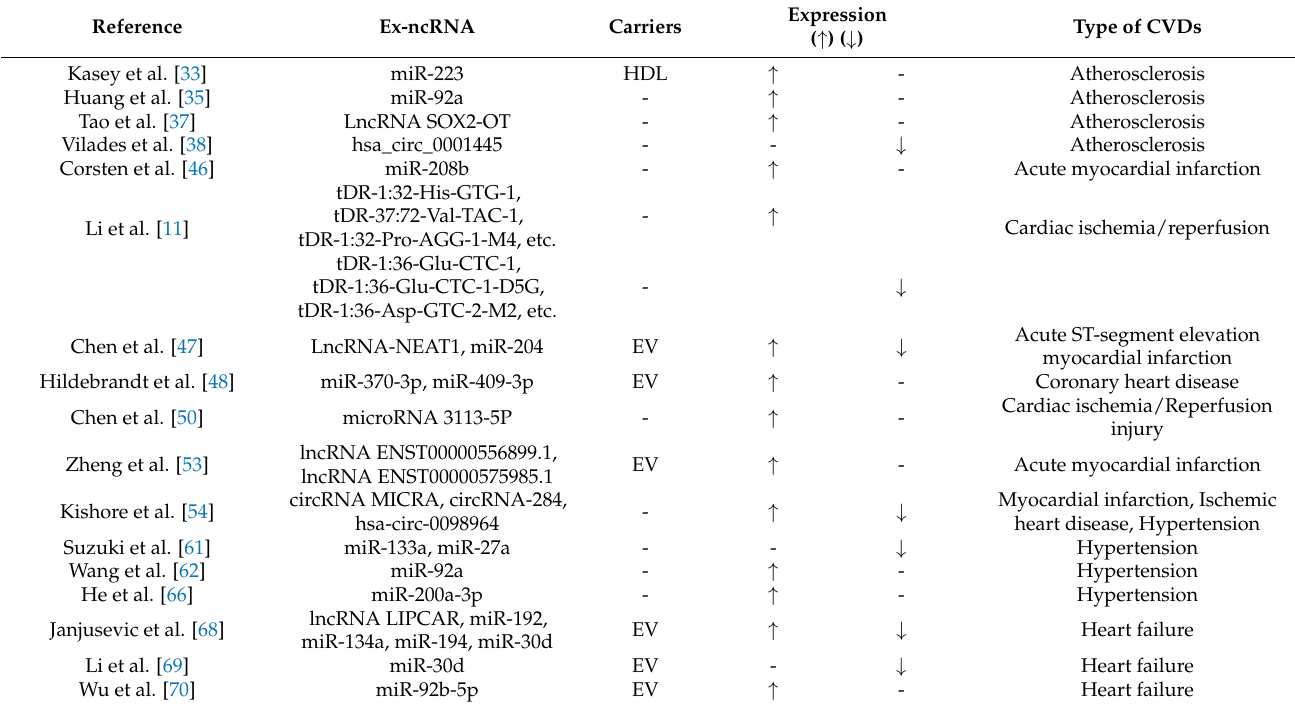
Table 1. Ex-ncRNAs as biomarkers in